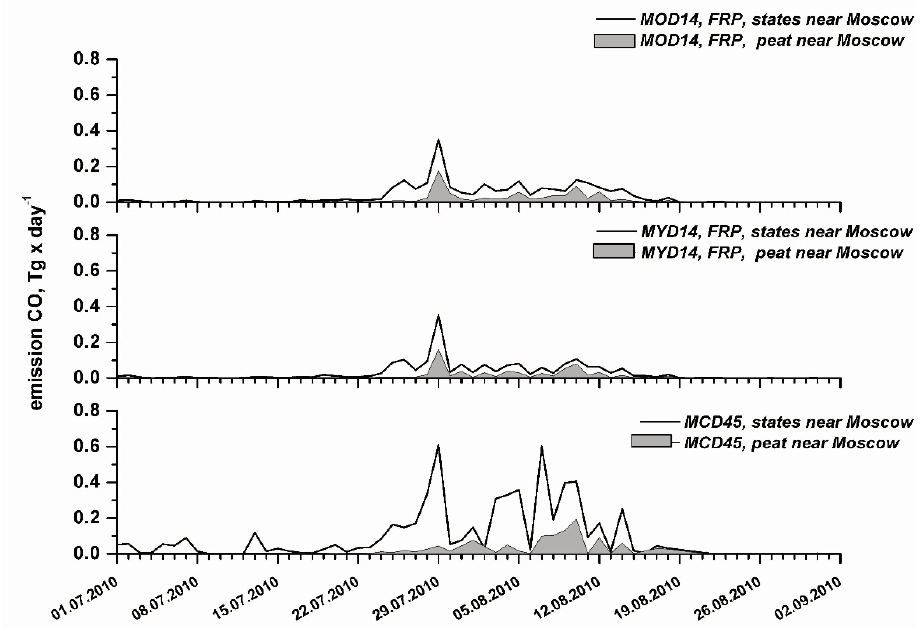
Figure 12. Daily CO emissions from wildfires in the central part of Russian plain between 1 July and 1 September, 2010. The emission values were calculated by FRP method (Equation (2)) with ignition localization by orbital data of MOD14 (Terra) и Aqua (MYD14) and by “Burned area” bulk method (Equation (1)) with ignition localization based on MCD45A1 data. The grey background color corresponds to peat areas (hatch areas in Figure